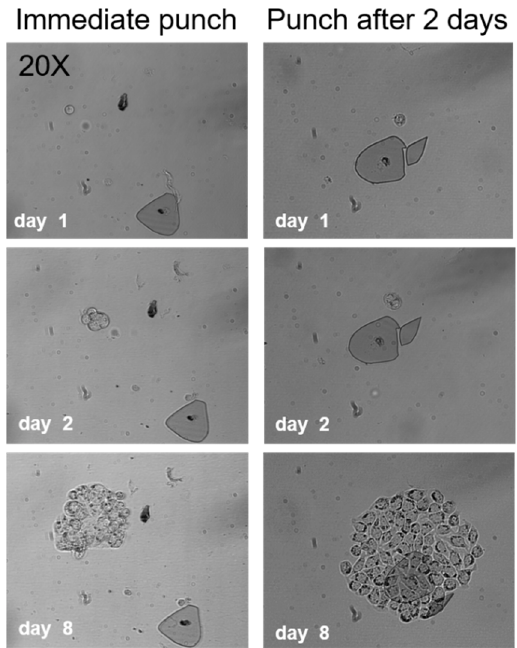
Figure 2. Growth pattern of single cells expanding after being punched from microwells into wells of a 96 well culture plate immediately after seeding (left) or two days after seeding (right), 20 × magnification was used for imaging.